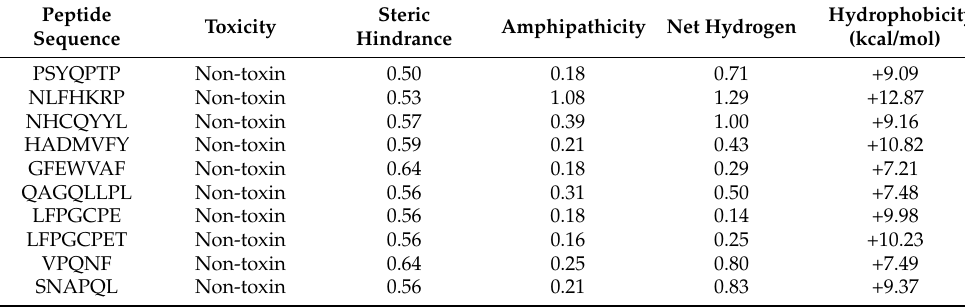
Table 6. Physicochemical properties of antioxidant peptides.